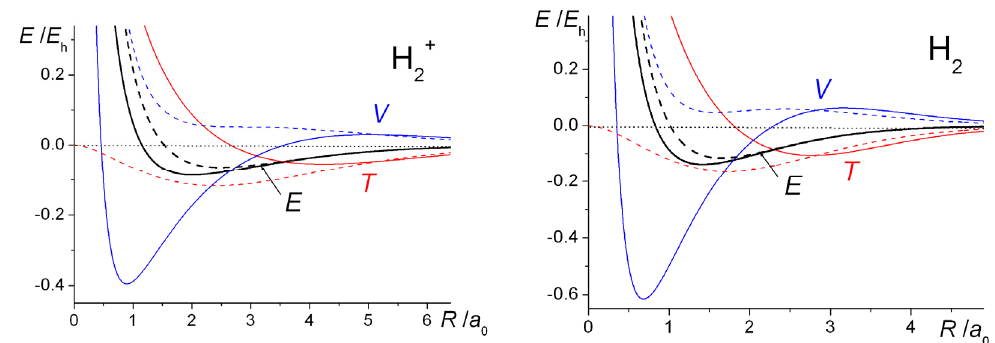
Figure 1. Energies of H 2 + and H 2 (valence-bond (VB)) (total energy E , kinetic energy T , potential energy V , all relative to the H and H + H atoms respectively), computed using minimal H 1 s atomic orbital (AO) basis with exponent ζ optimized (full lines) and fixed at the H atomic value of 1 (dashed lines). The qualitative similarities between the H 2 and H 2 energy curves are obvious. With the exponent